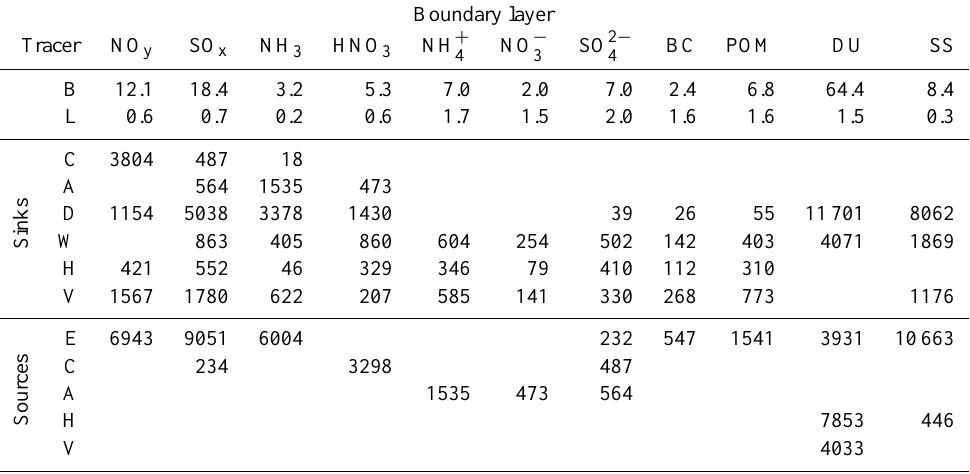
Table 3. European annual budget table of nine tracers for the boundary layer (surface up to 850hPa), with (B)urden, (L)ifetime; the sinks: (C)hemical reactions, (A)erosol condensation, (D)ry deposition, (W)et deposition, (H)orizontal transport and (V)ertical transport; and the sources: (E)mission, (C)hemical reactions, (A)erosol condensation, (H)orizontal transport and (V)ertical transport. Burdens (Gg) are averages of monthly samples. Lifetimes (days) are burdens divided by total sinks. Fluxes (Ggyr − 1 ) are annual totals. NO y includes NO, NO 2 , Peroxyacytyl nitrate (PAN), NO 3 , HNO 4 and N 2 O 5 , but no nitric acid or aerosol nitrate. SO x includes SO 2 and H 2 SO 4 , but no aerosol sulphate. Nitrogen compounds are expressed as masses N, sulphur compounds as masses S and sea salt as masses